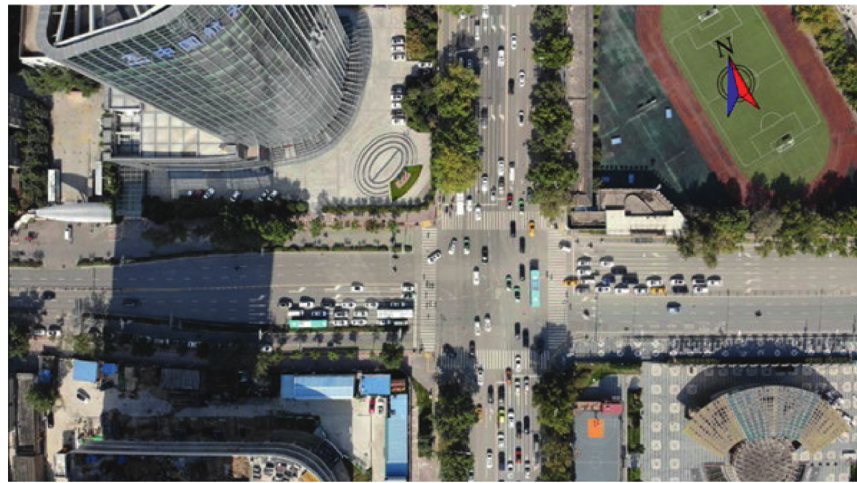
Figure 3: The actual situation of the investigated intersection. The investigated intersection is located in the center of Xi’an Yanta district. The east-west street is Dianzi Road, and the north-south street is Taibai South Road.